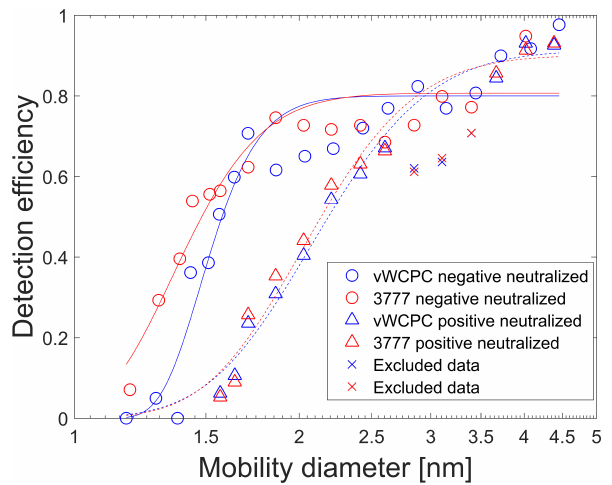
Figure 10. Concentration measured by the 3777 and vWCPC from urban atmospheric air.